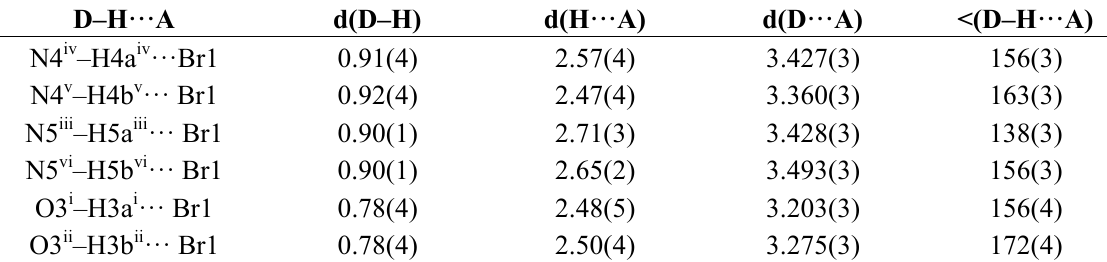
Table 6. Selected hydrogen bonds in the structure of 3 .